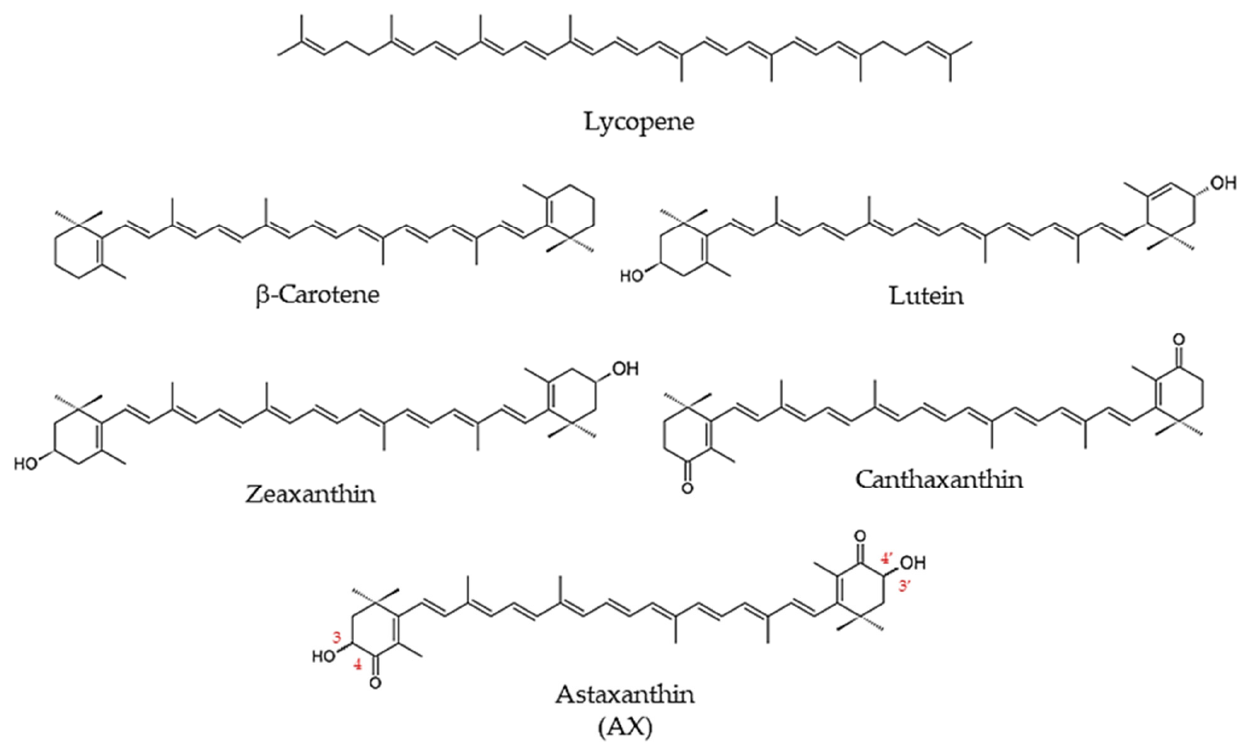
Figure 1. Structure of astaxanthin (AX) and related carotenoids.